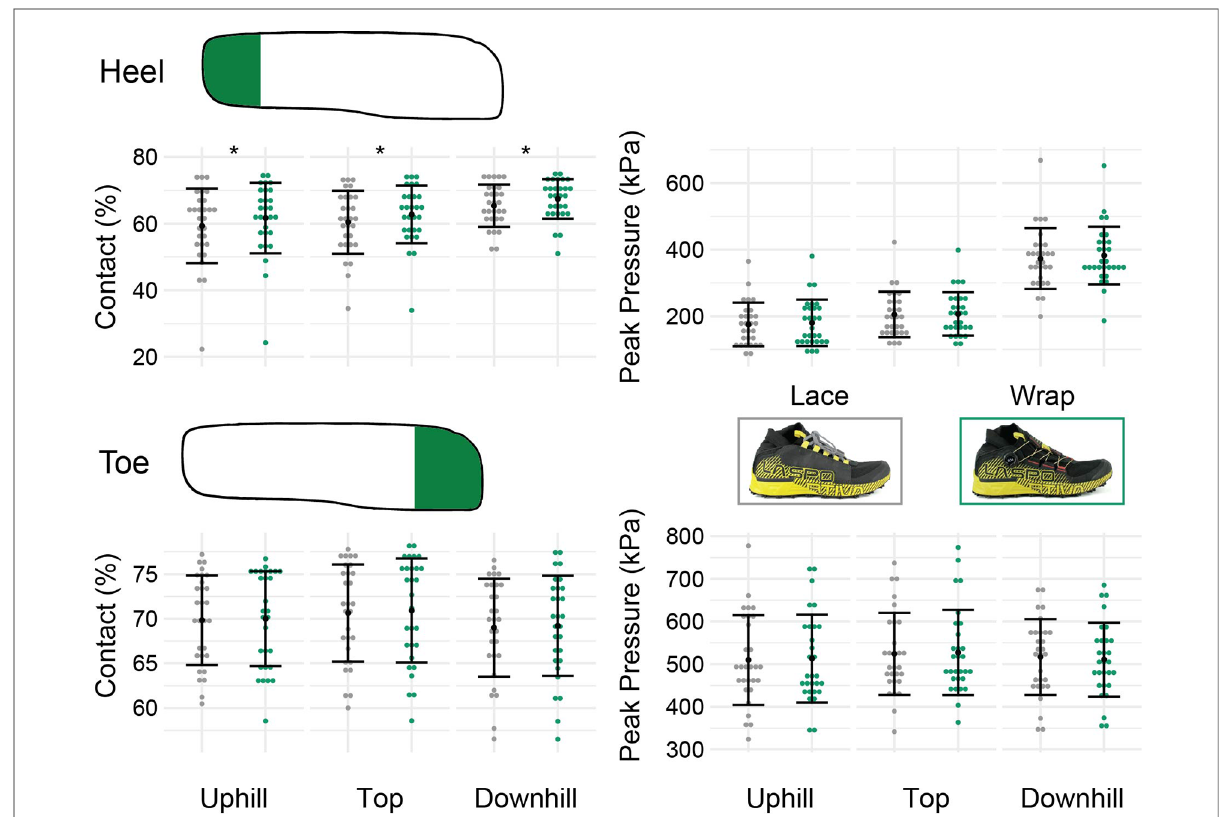
FIGURE 4 Plantar pressure outcomes. The top row are heel outcomes with a depiction of the heel region in the XSENSOR insoles. The bottom rows are toe outcomes with a depiction of the toe region in the XSENSOR insoles. The individual dots represent subject-average results. The black dots and adjoining error bars represent study averages and standard deviations ( N =29). Asterisks (*) indicate signi fi cant differences between the lace and the wrap shoes for each of the different sections of the